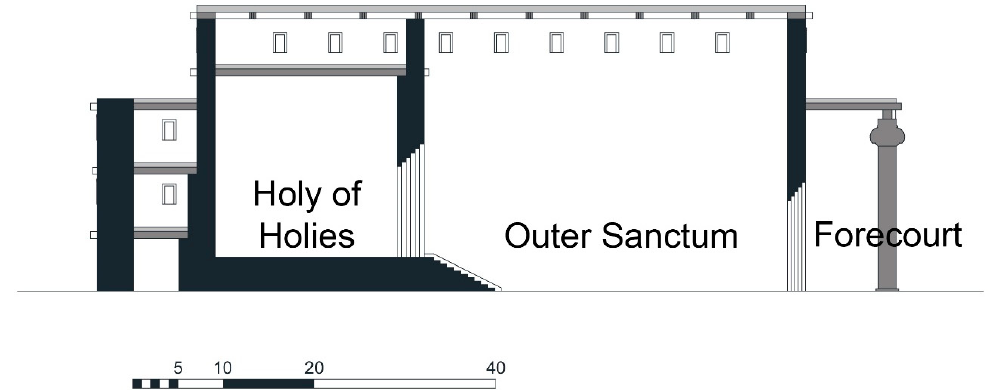
Figure 8. Longitudinal section through Solomon’s Temple based on our analysis of the text and relevant archaeological data.